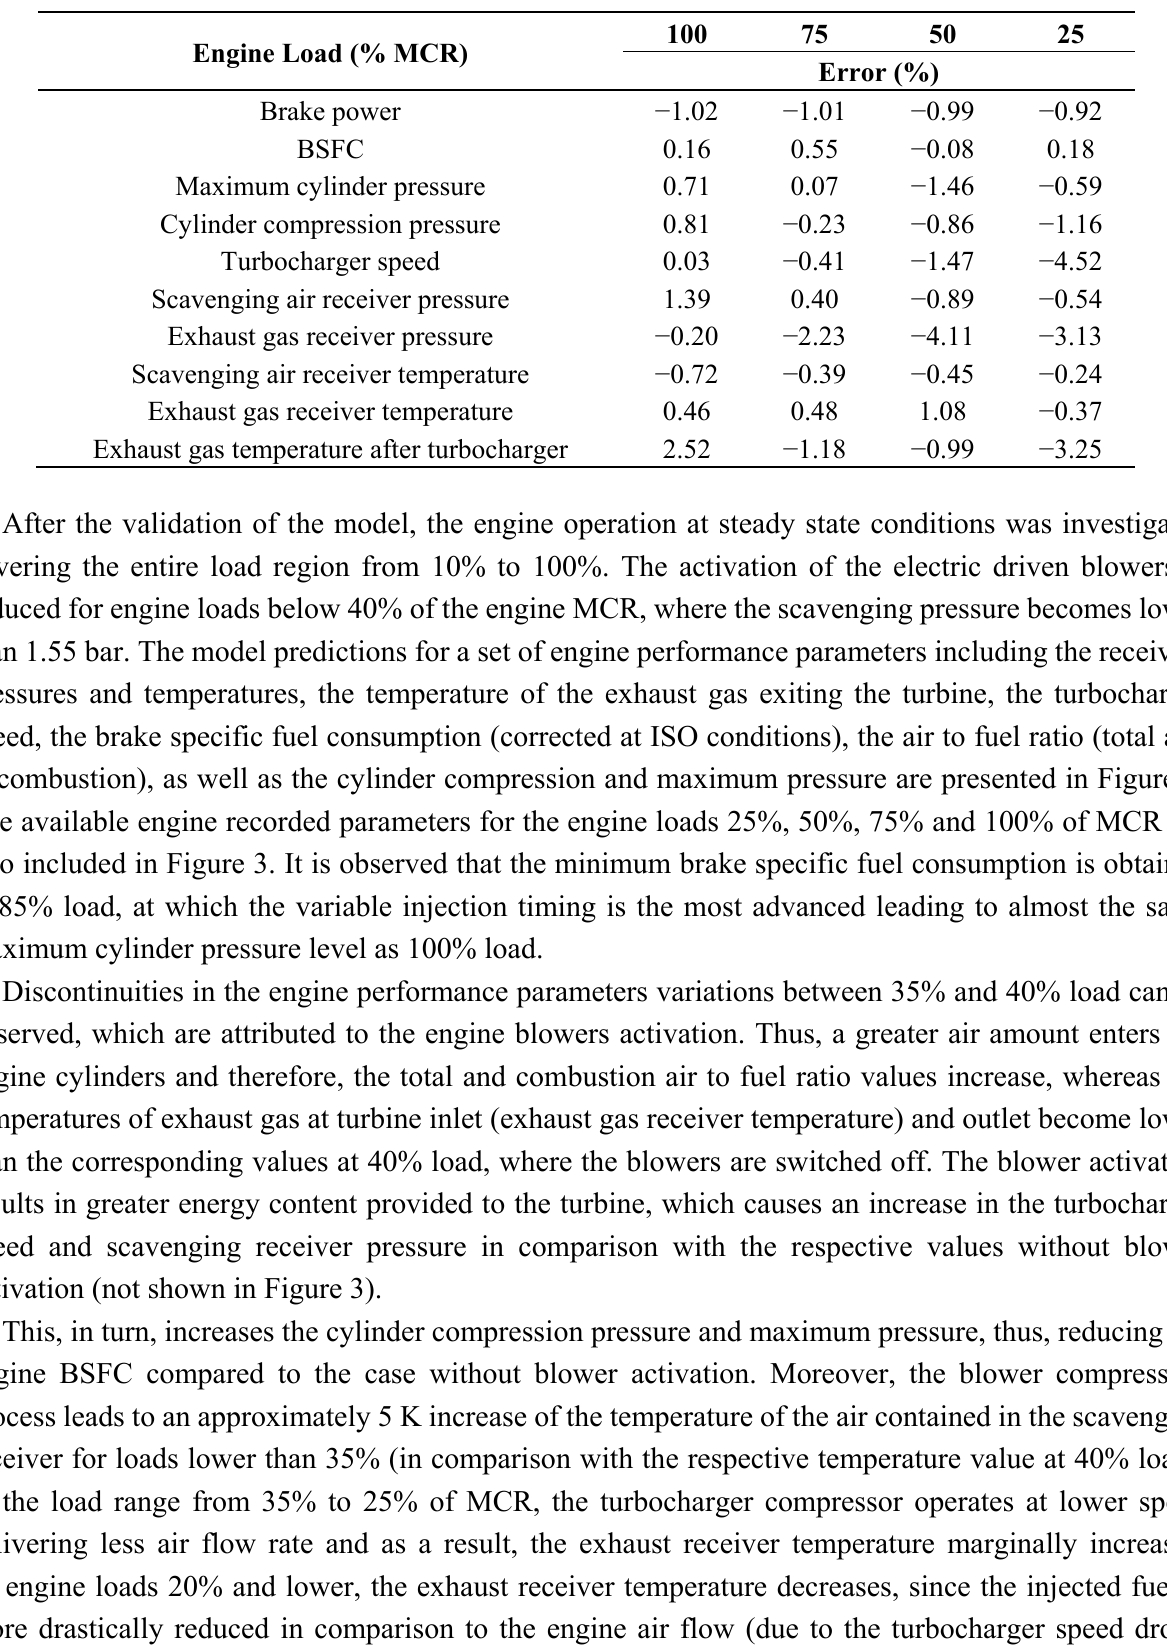
Table 2. Steady state simulation results, comparison with shop trials